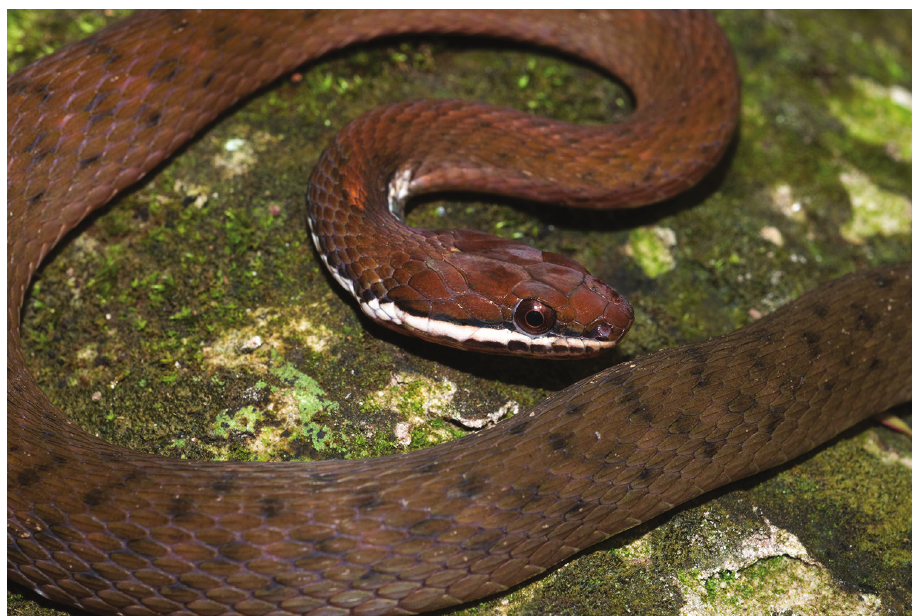
Figure 73. Rhabdophis lineatus (KU 334463) from Mt. Lumot, Municipality of Gingoog City, Misamis Oriental Province. Photo: